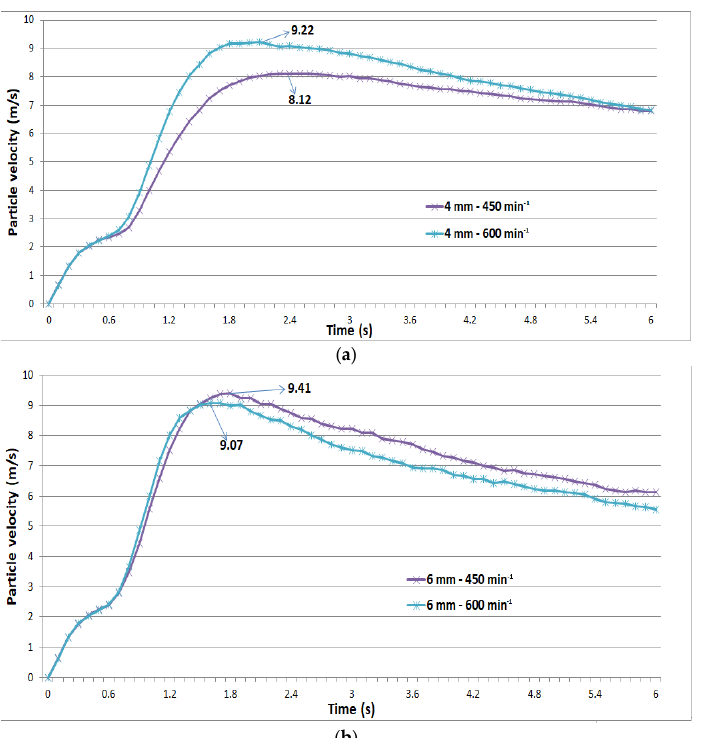
Figure 8. Average velocity of particles of the fertilizer I ( a ) and fertilizer II ( b ) when the discharge flow rate was 400 g s − 1 .